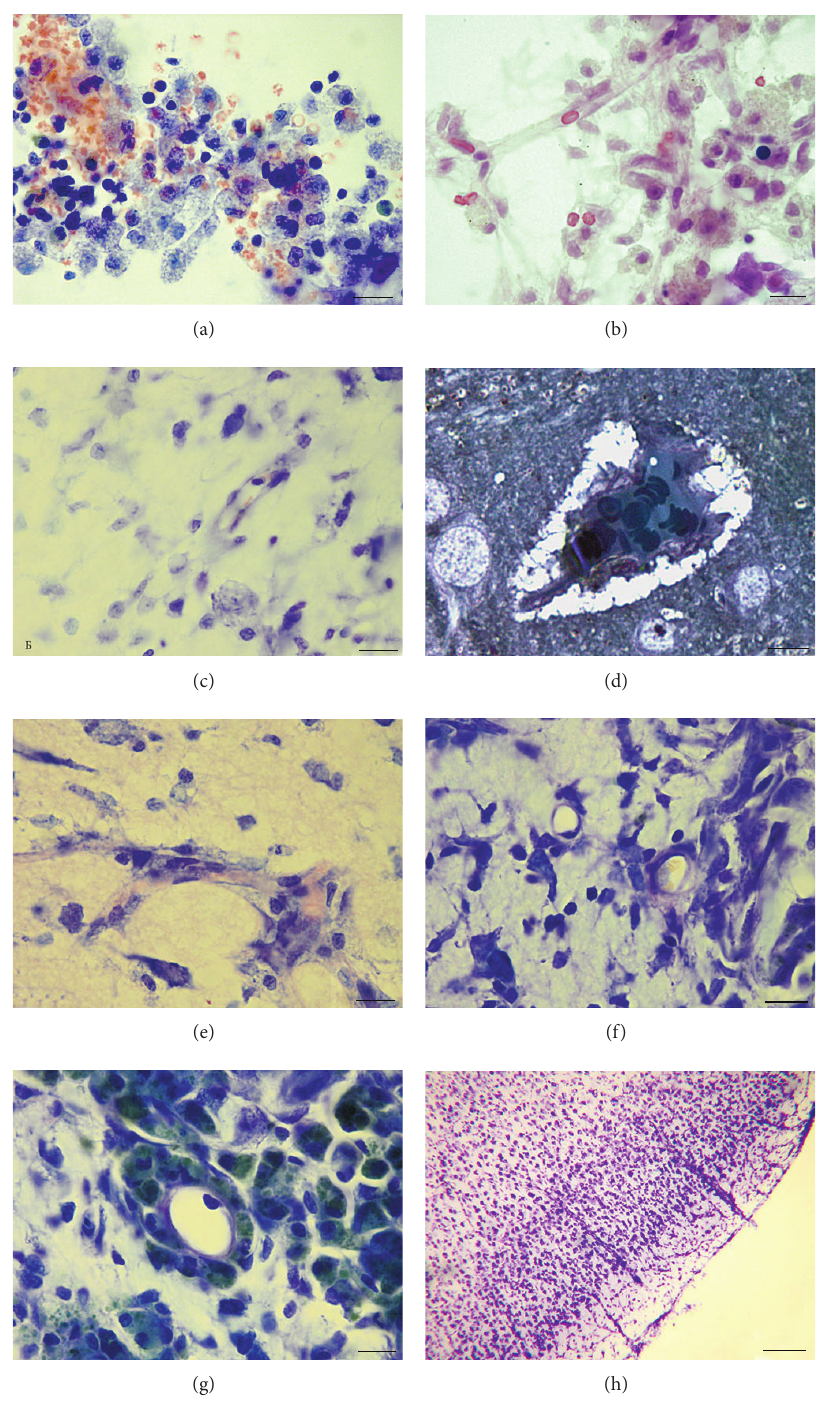
Figure 4: Morphological characteristics of groups 1 and 2. (a) Group 1: an infiltrate zone. Macrophages lying loosely are observed with the cytoplasm containing light granules. Erythrocytes effused out of the vessels in the image. (b) Group 1: infiltrate zone. Macrophages and newly formed capillary tubes are observed with an erythrocyte inside. (c) Group 1: penumbra. The cells of an infiltrate, a neuron, and a vessel with a thick wall in the section. (d) Group 1: penumbra. A blood vessel has hypertrophied walls; a circle of macrophages is absent. Perivascular edema. Semithin section. (e) Group 2: infiltrate zone. Branched vascular tree is filled with erythrocytes. (f) Group 2: penumbra zone. Infiltrate cells and venules with small diameters are observed. The wall of one of the vessels is thickened. (g) Group 2: infiltrate zone. Tightly packed macrophages filled with green granules are observed. Cross-section of a large vessel surrounded by a sphere of macrophages can be identified. (h) Group 2: rxternal part of the cortex, where there are hypertrophied vessels outside of the zone of injury. The scale bars in (a)–(g) are 20 𝜇 m, and in (h), 100 𝜇